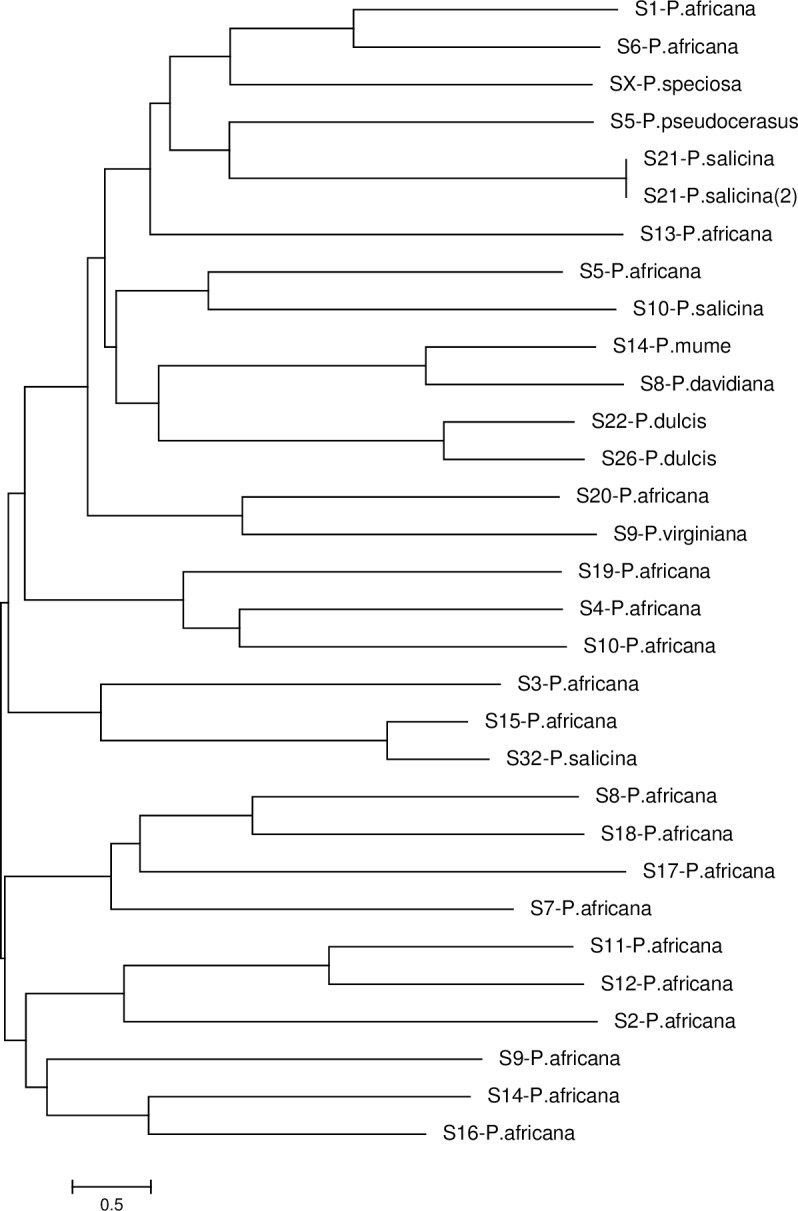
Phylogenetic tree (minimum evolution) of P. africana and other Prunus second intron S-RNase sequences depicting relationships with other congeneric species.Allele sequences are highly diverged and partially are similar to S-allele sequences obtained in other Prunus species, a pattern commonly observed as alleles are older than the species radiation.